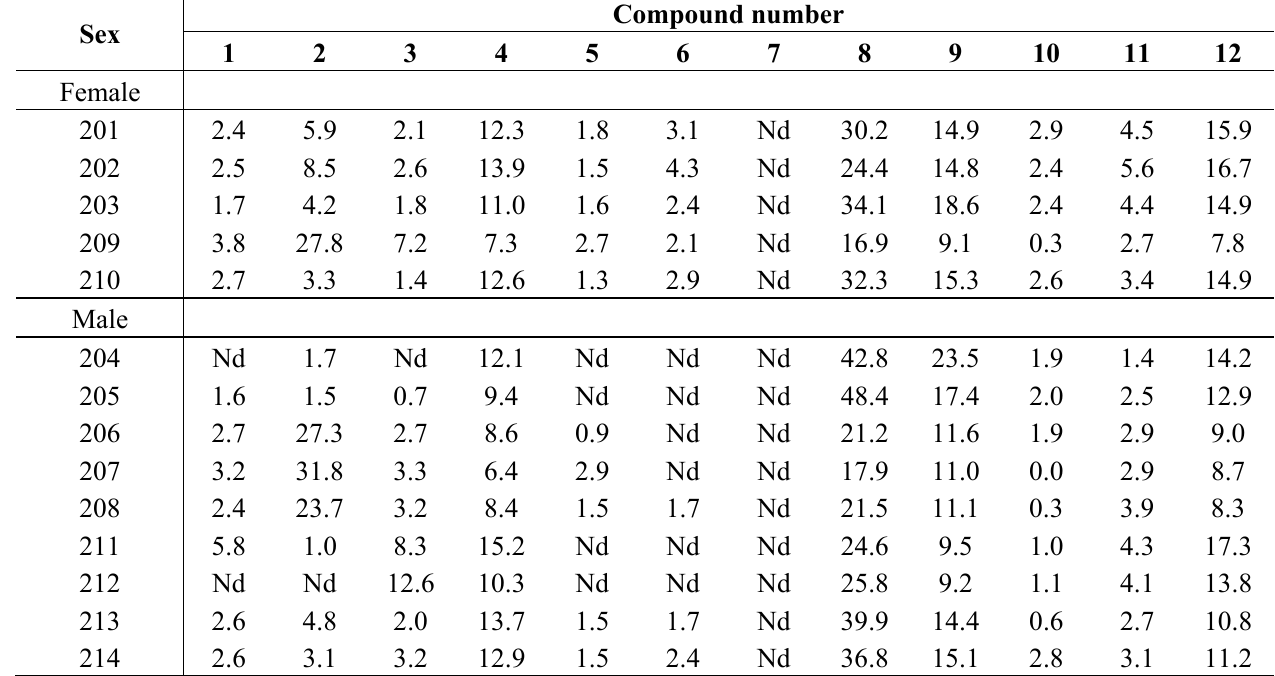
Table 3. Relative percent composition of the Austrocedrus chilensis resin diterpenes measured by GC-MS (as methyl esters). Samples collected in June 2011. Samples 201–203 and 209–210 are from female trees, 204–208 and 211–214 from male trees. Nd: not